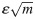
Performance of loop-scores vs spectral-biclustering applied to the planted-bicluster problem.For each instantiation of the planted-bicluster problem we choose an M, m, ε and l; we use these parameters to generate a random M × M matrix D and embedded m × m rank-l submatrix B with spectral noise ε. For each instantiation, our algorithm produces a list of row- and column-indices of D in the order in which they are eliminated; those rows and columns retained the longest are expected to be members of B. To assess the success of our algorithm we calculate the auc AR (i.e., area under the receiver operator characteristic curve) associated with the row-indices of B with respect to the output list from our algorithm. The value AR is equal to the probability that: given a randomly chosen row from B as well as a randomly chosen row from outside of B, our algorithm eliminates the latter before the former (i.e., the latter is lower on our list than the former); We calculate the auc AC for the columns similarly. Finally, we use A = (AR + AC)/2 as a metric of success; values of A near 1 mean that the rows and columns of B were filtered to the top by our algorithm, whereas values of A near 0.5 mean that our algorithm failed to detect B. In the top of Panel-A we show the trial-averaged auc A for our loop-counting method as a function of εm and logM (m). Results for l = 1 are shown on the left; l = 2 is shown on the right. Each subplot takes the form of a heatmap, with each pixel showing the value of A for a given value of log10(εm) and logM (m) (averaged over at least 128 trials). The different subplots correspond to different values for M. Note that our loop-counting algorithm is generally successful when log10(εm)≲0 and logM(m)≳0.5. In the bottom of Panel-A we show the analogous auc A for a simple implementation of the spectral method (see section A22 of S2 Text). In Panel-B we show the difference in trial-averaged A between these two methods (see colorbar for scale). Note that when l ≥ 2 or the noise is small, our loop-score generally has a higher rate of success than the spectral method. On the other hand, there do exist parameters when l = 1 and εm∼1 where the spectral method has a higher rate of success. In each panel the thin grey line shows the detection-boundary for our loop-counting method (calculated using m3(2gl,ε,m−1)=2M3).